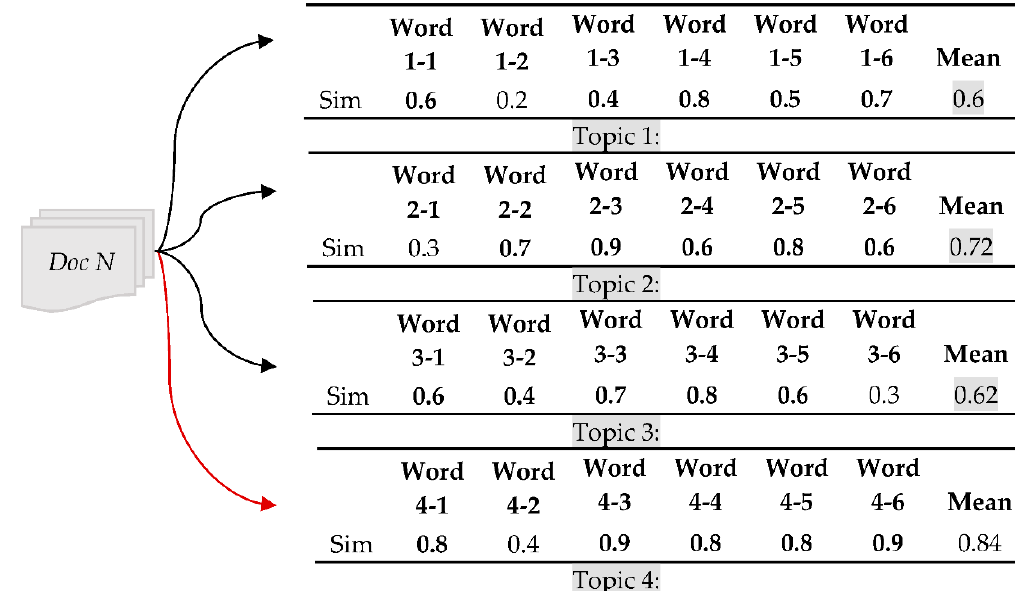
Figure 5. Method of document topic determination.